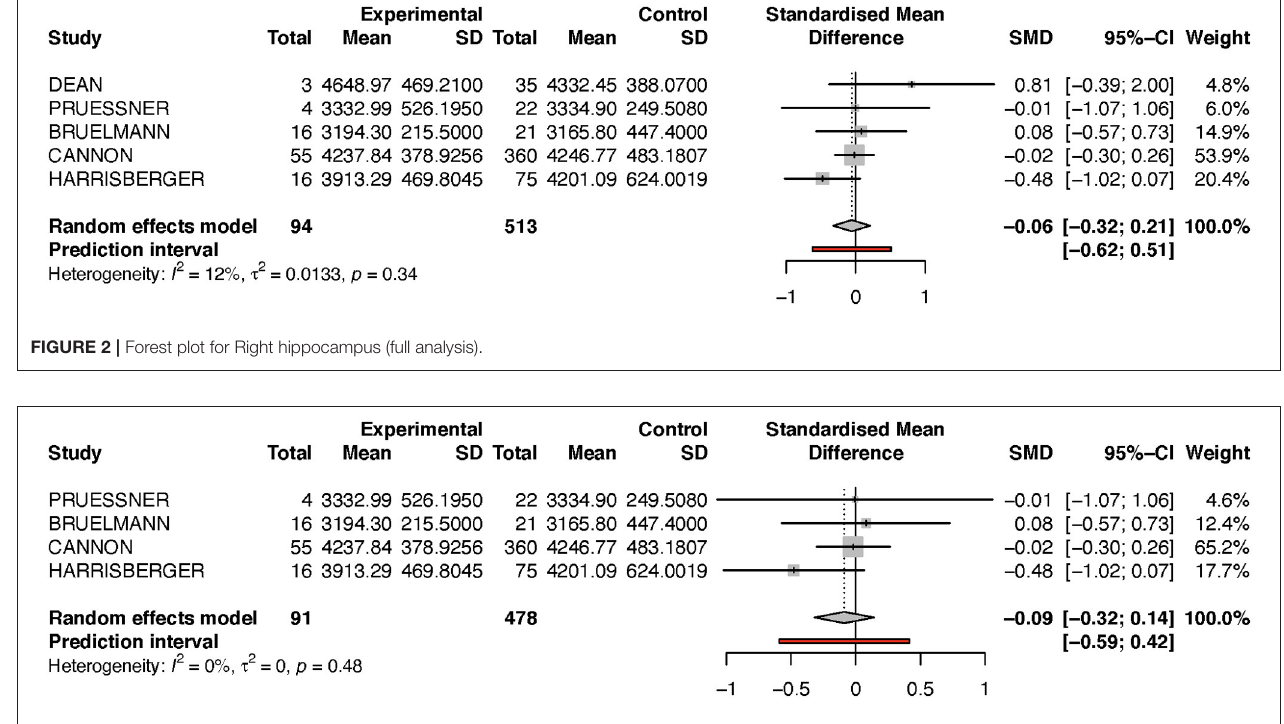
FIGURE 3 | Forest plot for Right hippocampus (sensitivity